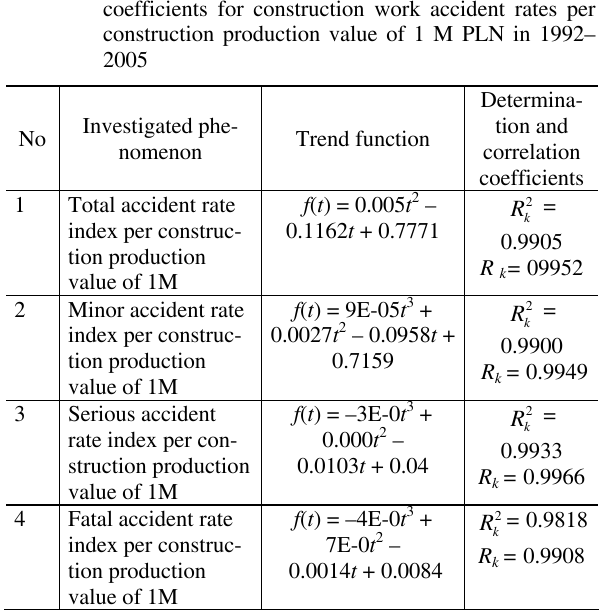
Table 3. Trend functions and determination and